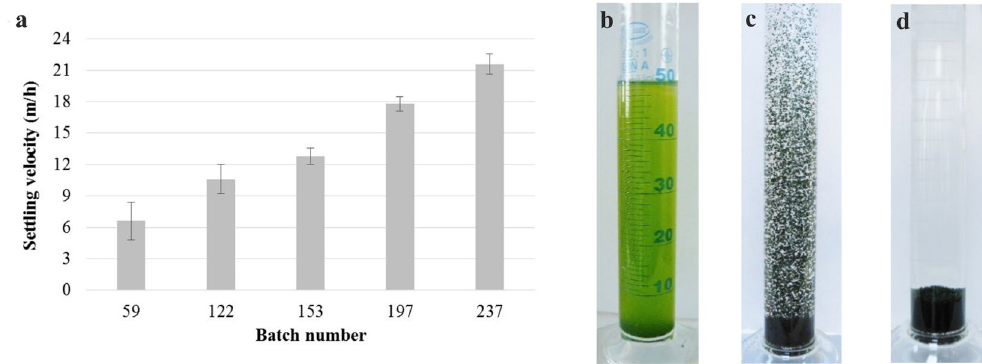
Figure 7. The influence of activated algae granules development on biomass settling velocity. ( a ) Settling rate of the activated algae biomass recorded during the granulation procedure in respect to the investigated batch number. ( b ) Sedimentation of the activated algae flocs (after 1 h), the free target microalgae cells ( Chlorella sp.) remaining suspended due to their small cell size, and mature activated algae granules: ( c ) in the first seconds of the settling phase and ( d ) after 2 min of